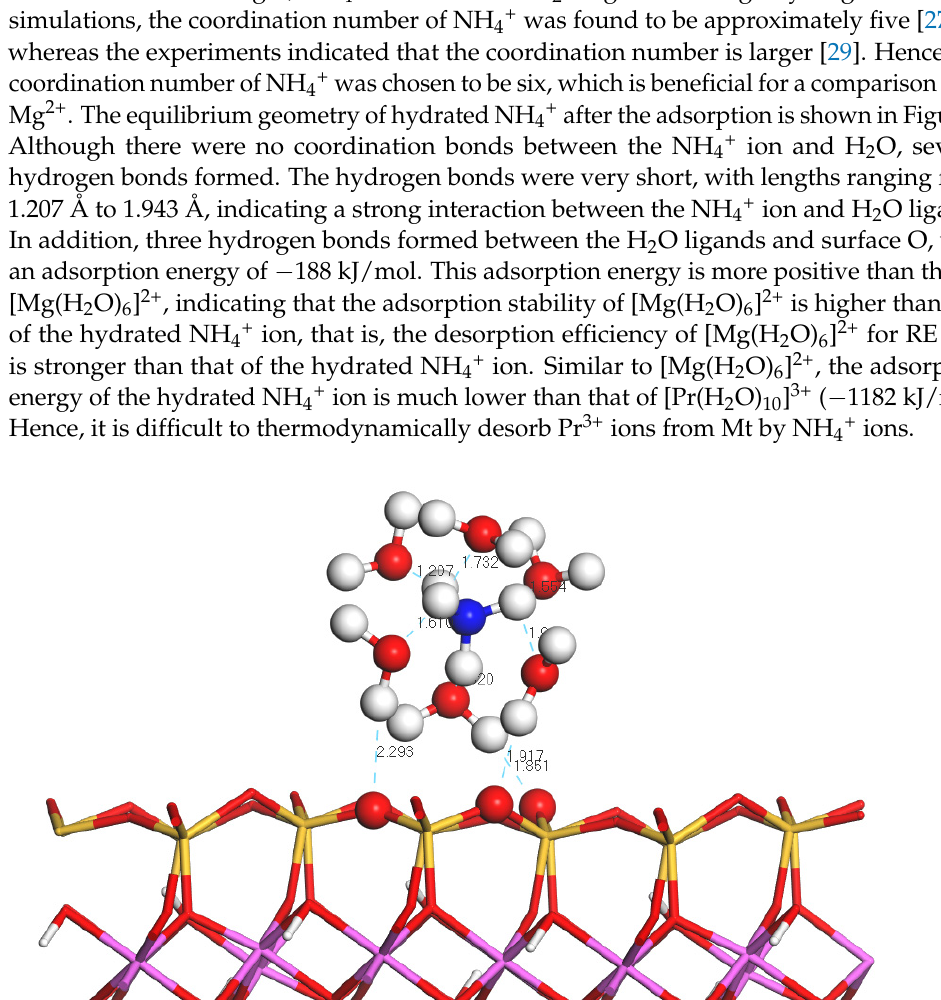
NH before adsorption s 4 Surface before adsorption NH 4 after adsorption −20 −30 Surface after adsorption D e n s i t y o f s t a t e s ( e l ec t r on es / e V ) 20 Figure 8. PDOS of NH 4 and (001) surface of Mt before and after adsorption.